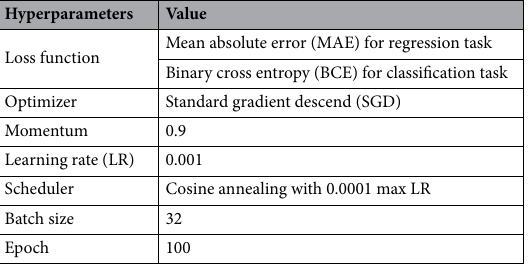
Table 4. Hyperparameters used in the training of the proposed